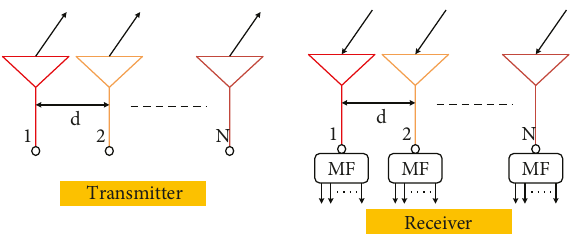
Figure 1: Illustration of FDA-MIMO radar